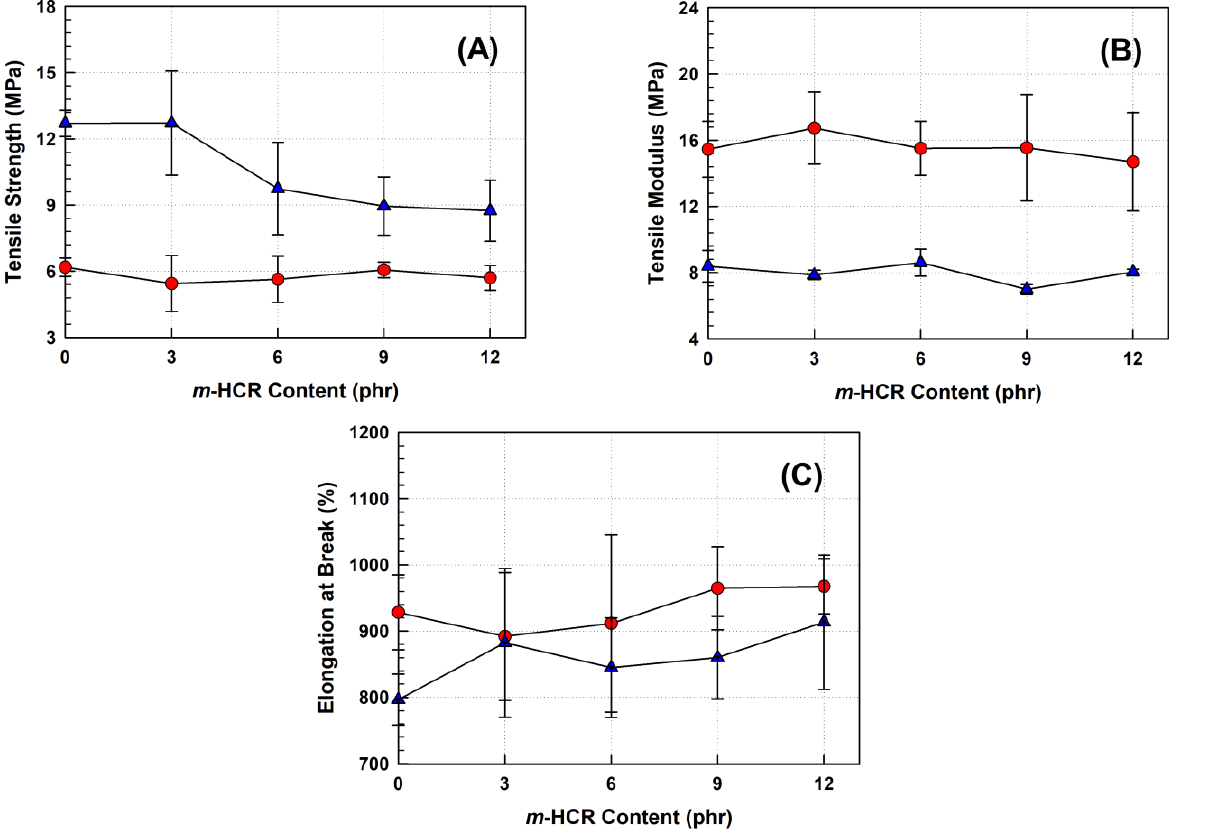
Figure 5. The tensile strength ( A ), tensile modulus ( B ), and elongation at break ( C ) behaviors of the neat POE and POE blends with m -HCR before and after crosslinking: ( ⏺ , uncrosslinked samples; ▲ , crosslinked samples).